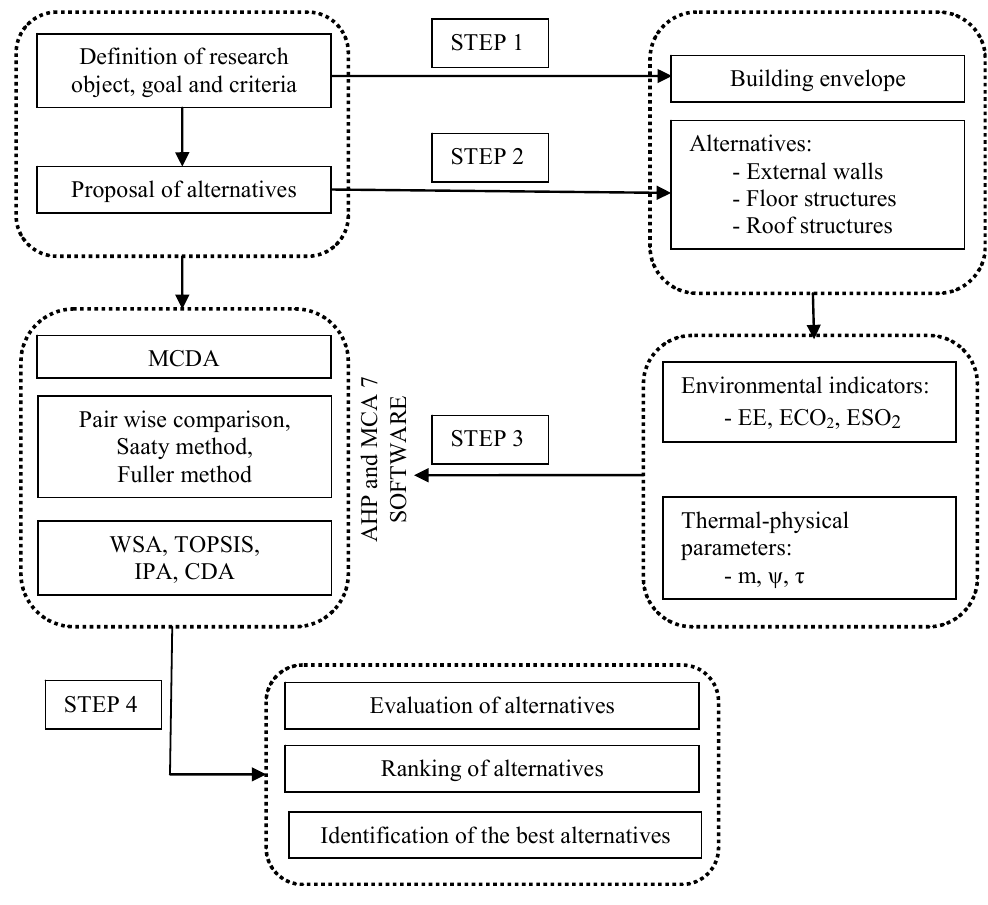
Figure 1. Flowchart of